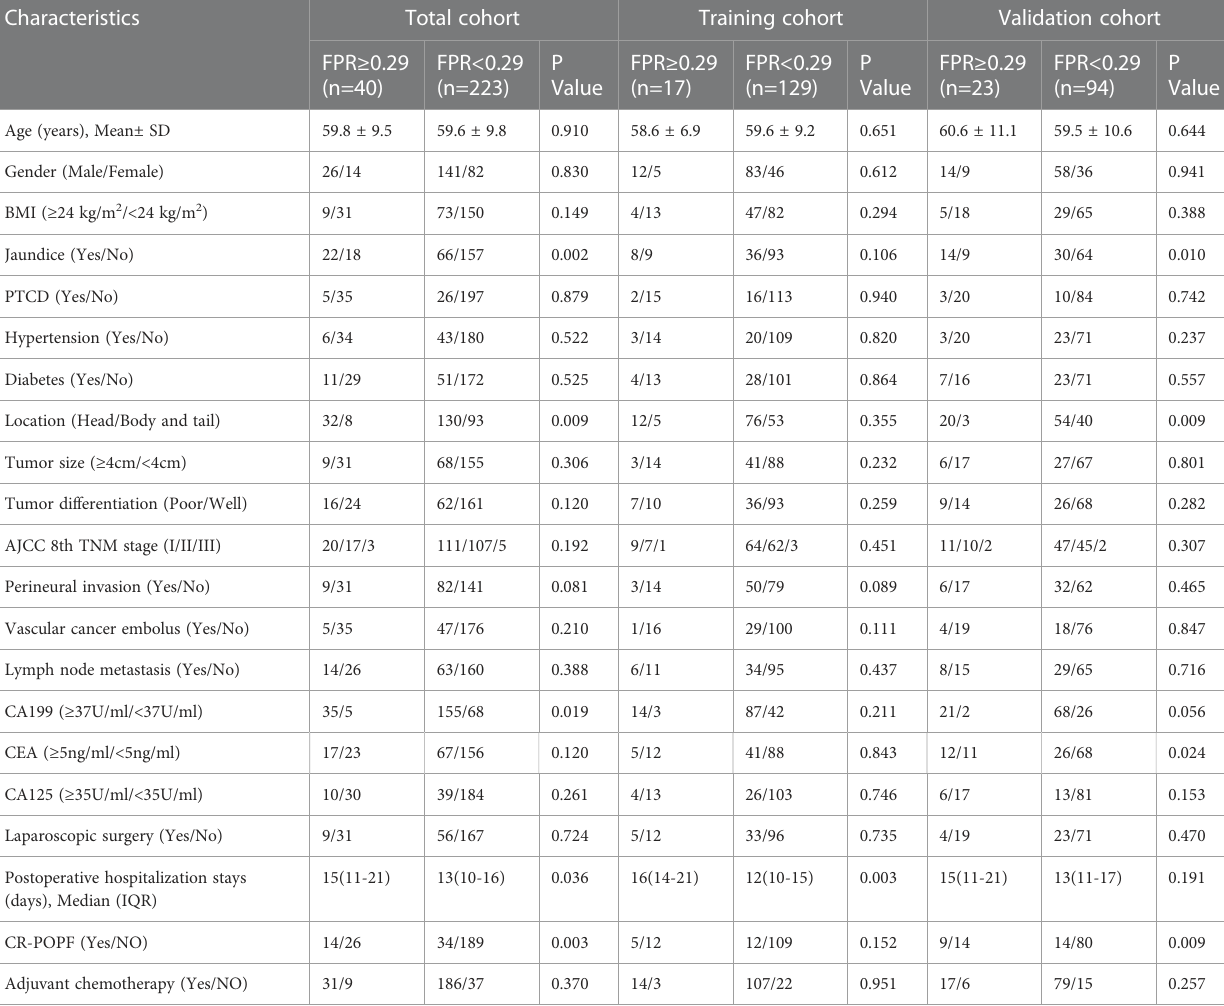
TABLE 2 Correlations between FPR and clinicopathological